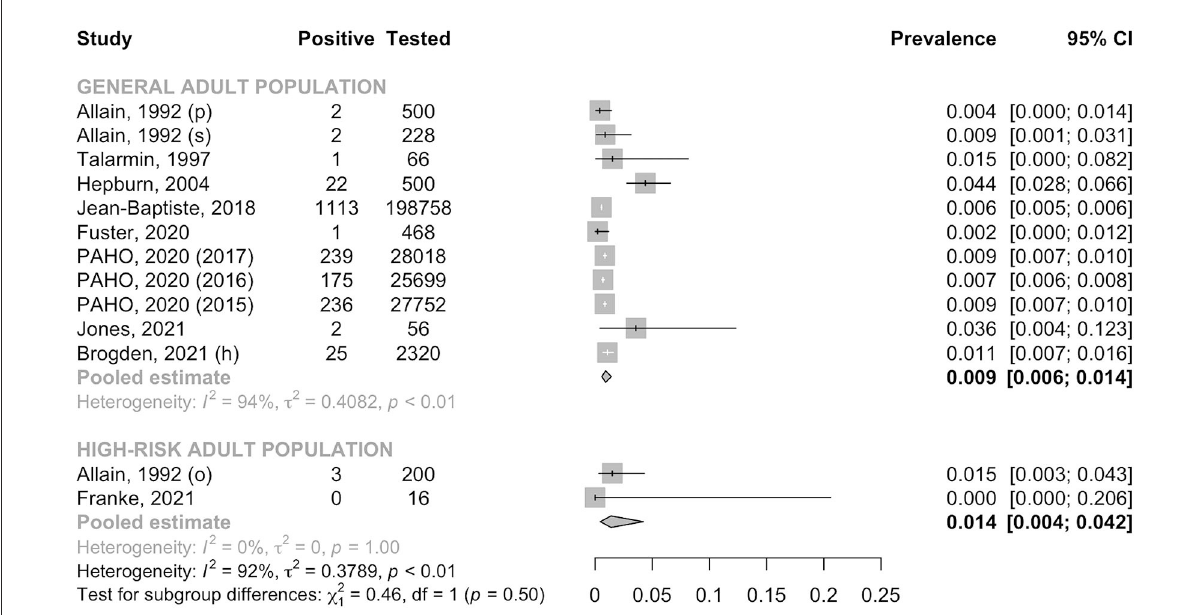
FIGURE6 Prevalence of anti-HCV antibody in the general adult population and the high-risk adult population. h, hospital recruitment; o, outpatient; p, pregnant women; PAHO, Pan American Health Organization; s, surgery patient.